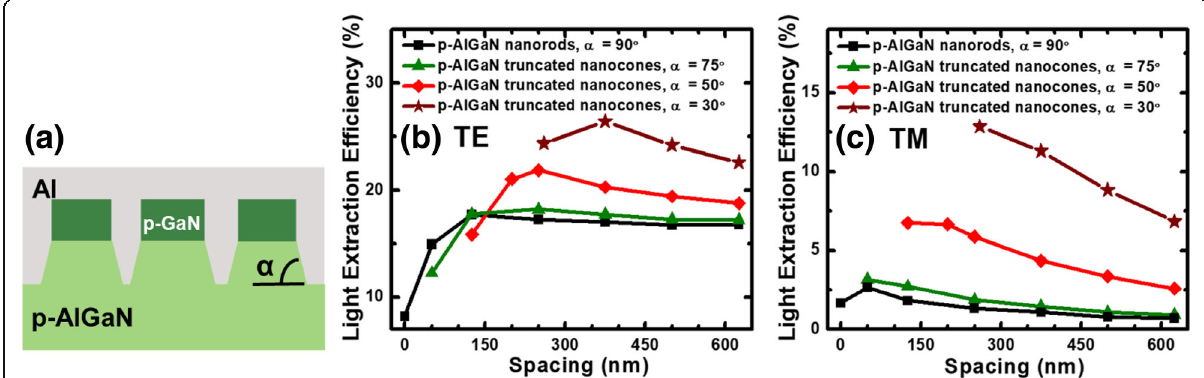
Fig. 6 a Schematic side view diagram for flip-chip DUV LED with hybrid p-GaN nanorod/p-AlGaN truncated nanocone contacts. LEEs of TE- polarized light ( b ) and of TM-polarized light ( c ) as a function of the nanorod spacing for DUV LEDs, and the structures are with the 100-nm-high p-GaN and 75-nm-high p-AlGaN (the inclined angles are set to 30°, 50°, 75°, and